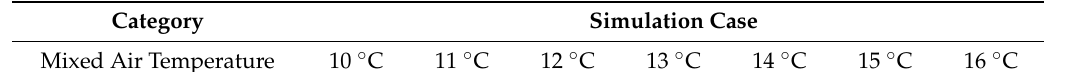
Table 6. Energy evaluation.